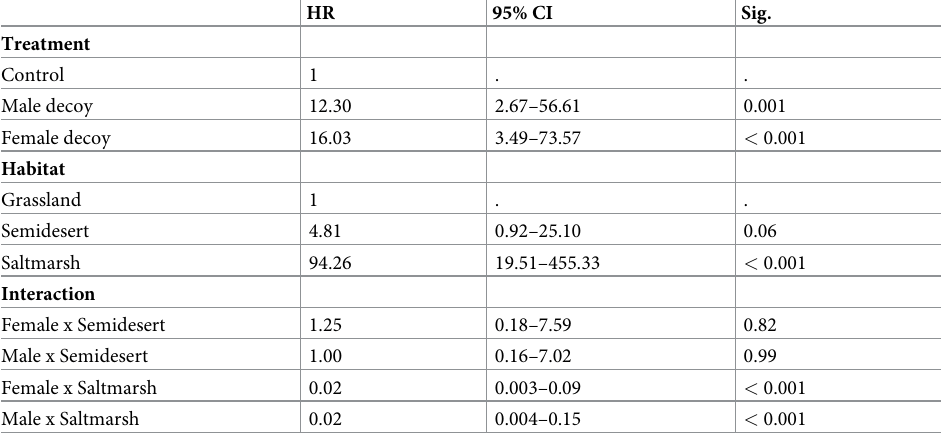
Table 4. Nest survival in relation to treatment (male decoy, female decoy and control) and habitat (Grassland, Saltmarsh and Semidesert). HR 95% CI Sig.